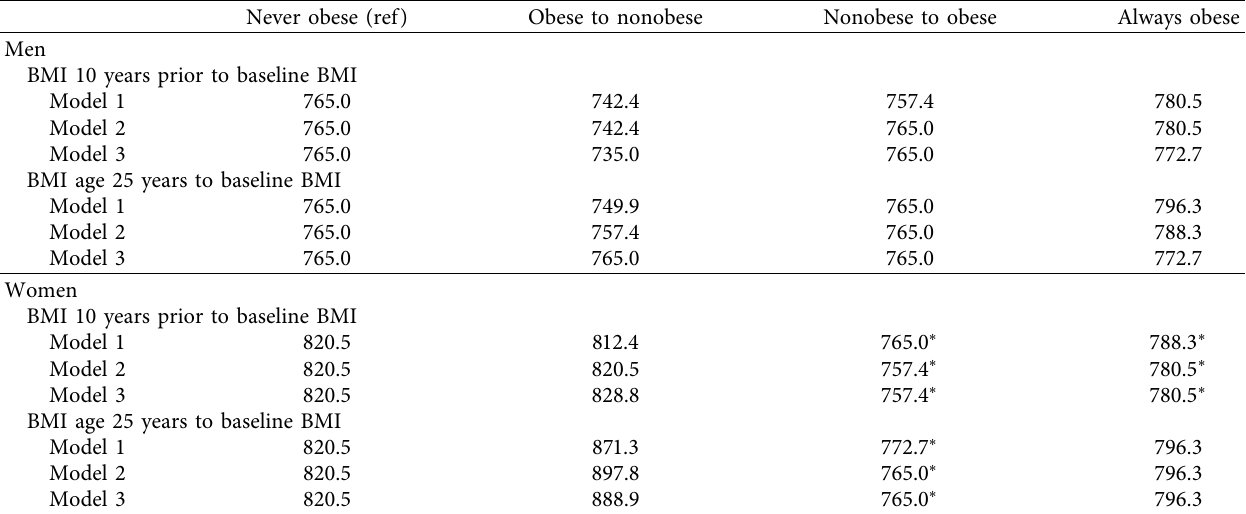
Table 2: Weight change pattern and serum soluble klotho levels (pg/ml) in men and women aged 40–79 years. Never obese (ref) Obese to nonobese Nonobese to obese Always